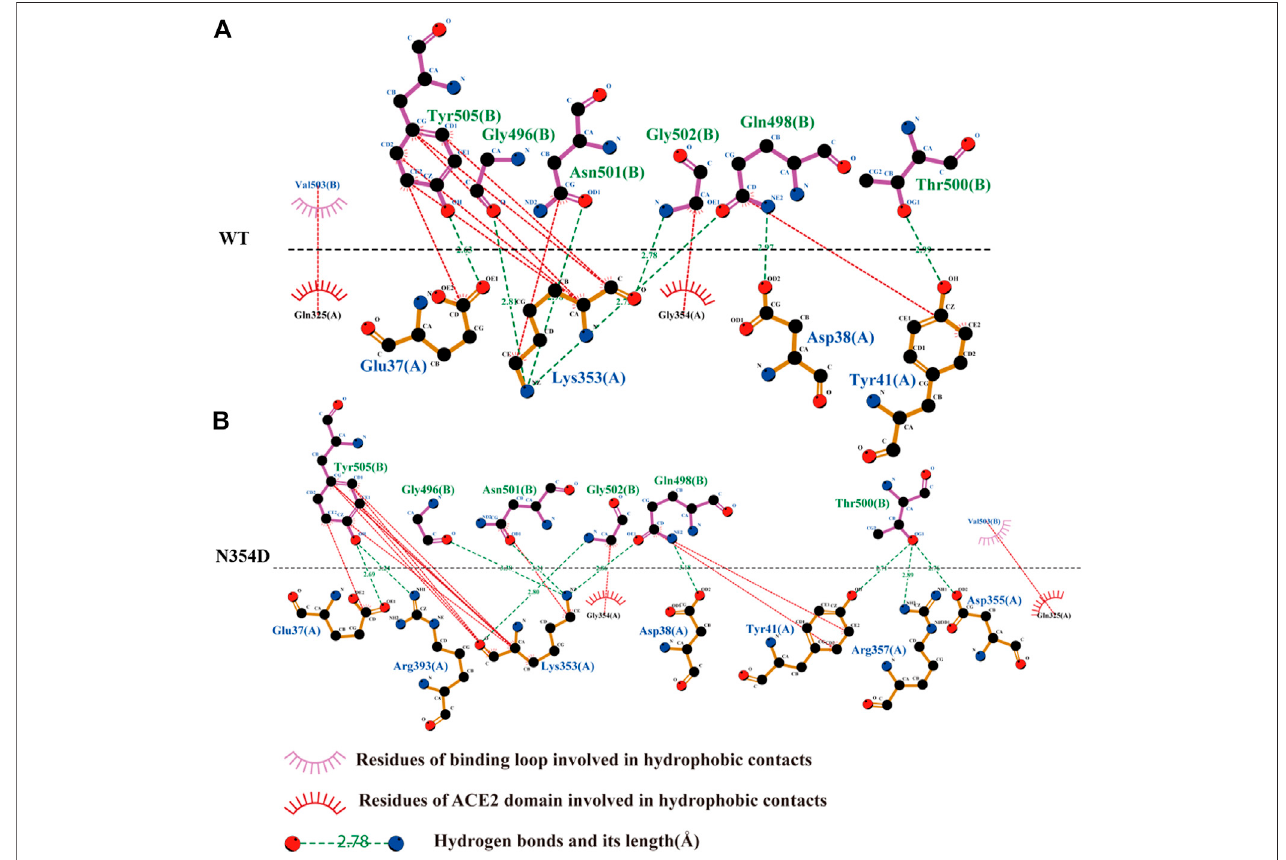
FIGURE 6 | Network of interactions associated with binding loop in RBD derived from Ligplot+ software analysis. (A) Analysis of hydrogen bond and hydrophobic interaction of binding interface in the WT system. (B) N354D system.